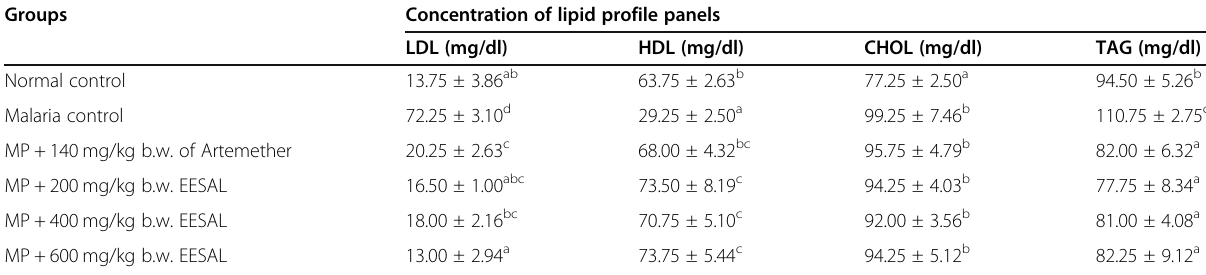
Table 7 Effect of the EESAL on lipid profile of Plasmodium berghei -passaged mice